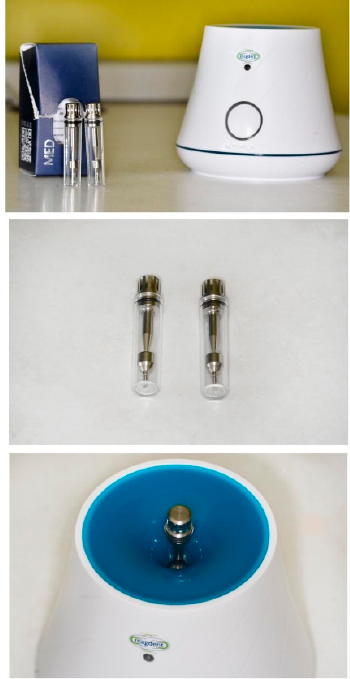
Figure 7. Magdent™ pulse electromagnetic healing caps.